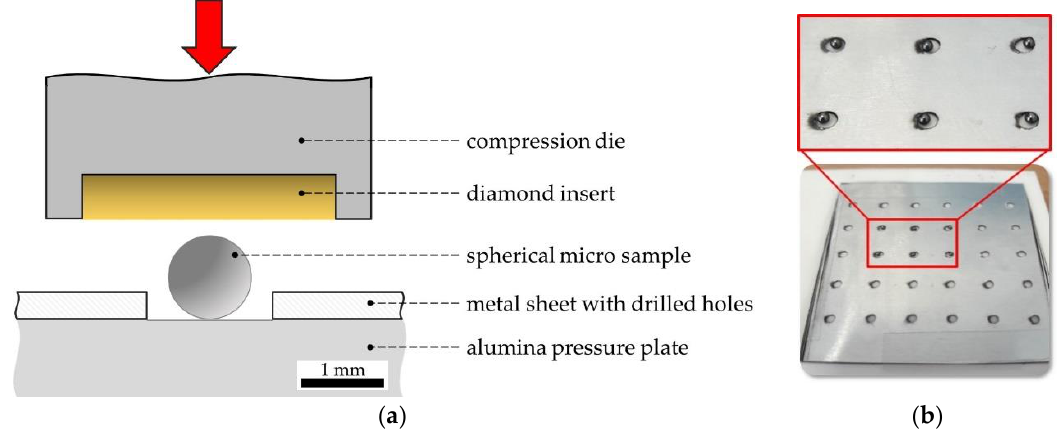
Figure 4. Experimental test setup of the compression test on spherical micro samples: ( a ) Sketch and labels; ( b ) photo of the positioning setup.